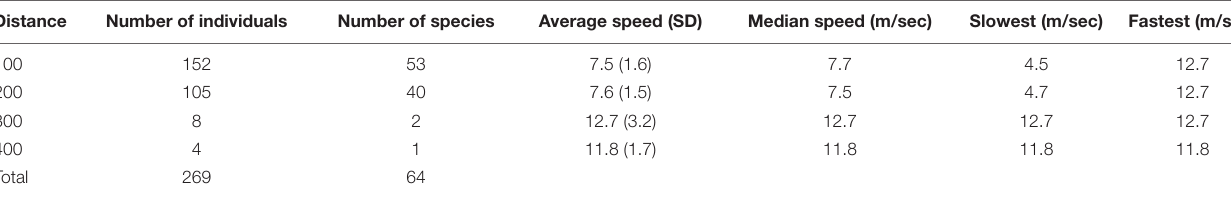
TABLE 2 | Summary of flight speed estimates obtained during the dispersal experiments on the Rio Branco. Distance Number of